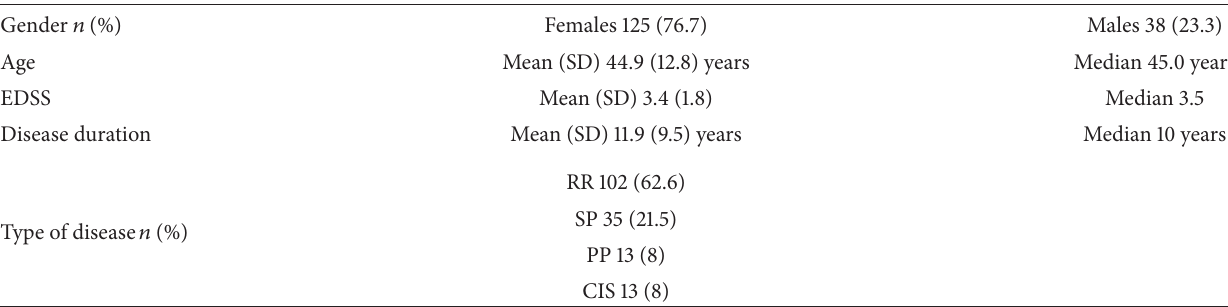
Table 1: Characteristics of